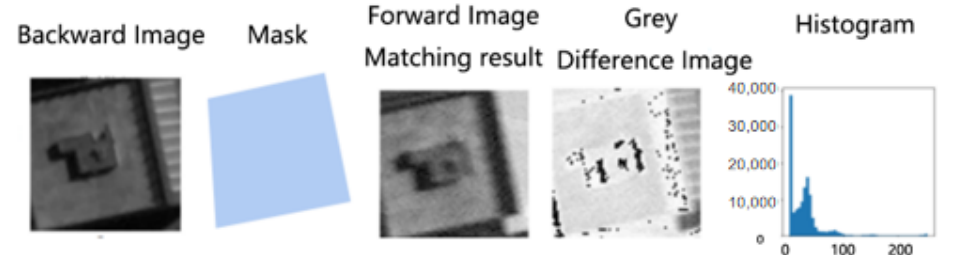
Figure 6. A single building matching based on masked gray difference.